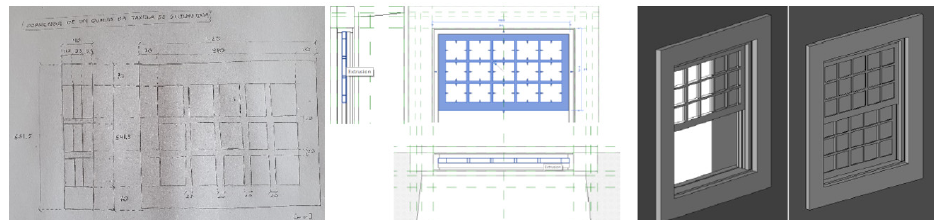
Figure 16. Modelling of two panels of the guillotine window.